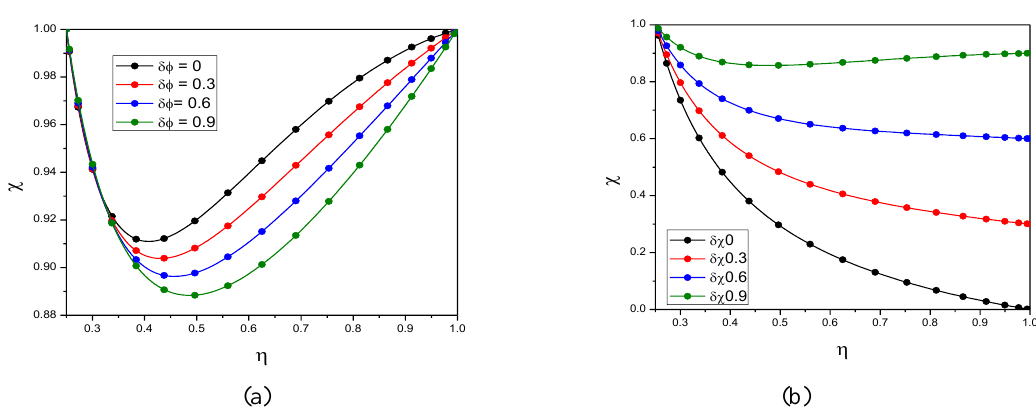
Figure 3. Profiles of 𝜒 w.r.t. the slip parameters in concentration and motile-microorganism 𝛿𝜙 ,